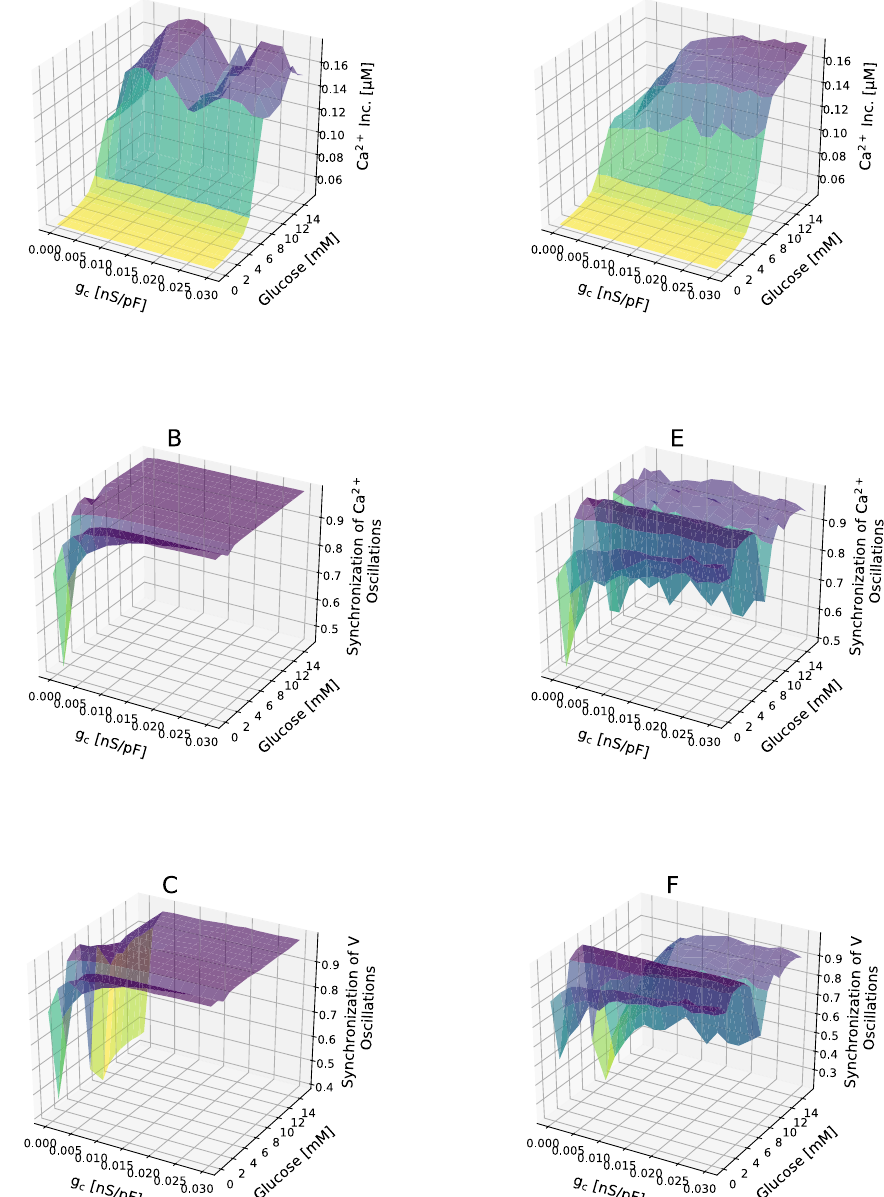
Figure 4. ( A – C ) The interplay between gap junction coupling strength and glucose concentration in the mean [ Ca 2 + ] c response, and in the synchronization of [ Ca 2 + ] c and membrane potential oscillations across the intact islet. ( D – F ) As in panels ( A – C ), but across the islet lacking ∼ 55% β -cells. Note that after loss of ∼ 55% β -cell mass the level of intracellular Ca 2 + is more slowly saturated, and the islet synchronization is more sensitive to increasing glucose level. Data represent the mean ± S.E.M. over 10 modeled